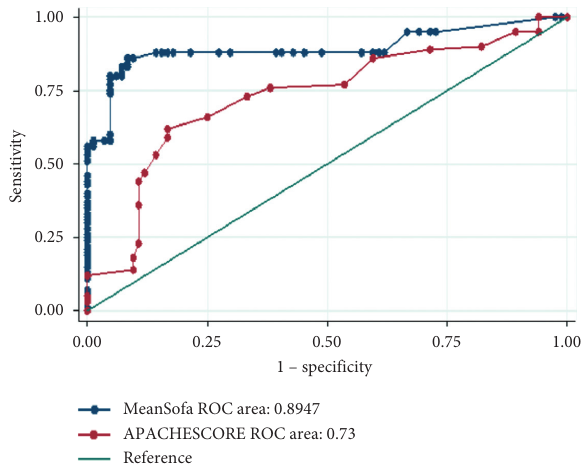
Figure 1: Comparison of the ROC for mean SOFA and APACHE II score of patients hospitalized for COVID-19 at ICU. APACHE II: acute physiology and chronic health evaluation, SOFA: sequential organ failure assessment. Table 3: Based on organic complications in survive and nonsurvive